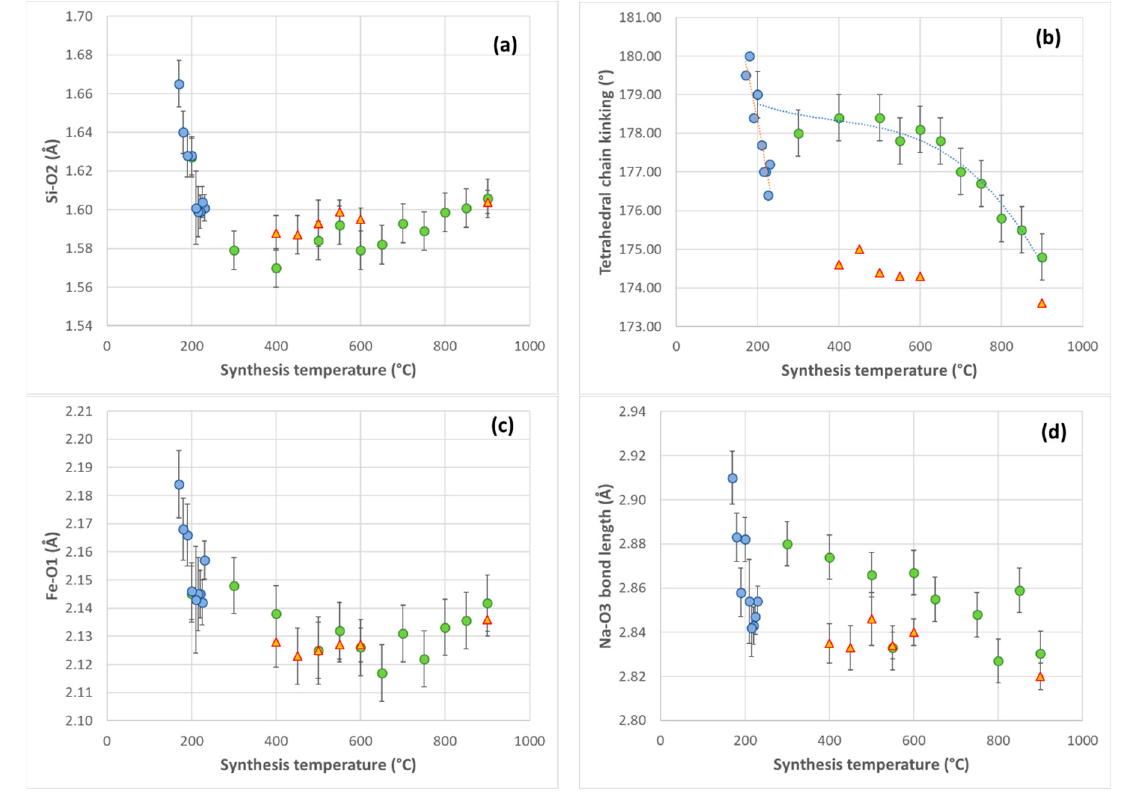
Figure 7. Variations of selected structural parameters of aegirine, synthesized and treated at different temperatures, parameters determined from Rietveld analysis of X-ray powder diffraction data: ( a ) variation of the Si–O2 bond lengths with synthesis temperature, ( b ) variation of the tetrahedral bridging angle O3–O3–O3 with synthesis temperature, ( c ) variation of the Fe–O1 bond lengths with synthesis temperature and ( d ) variation of the Na–O3 bond lengths with synthesis temperature